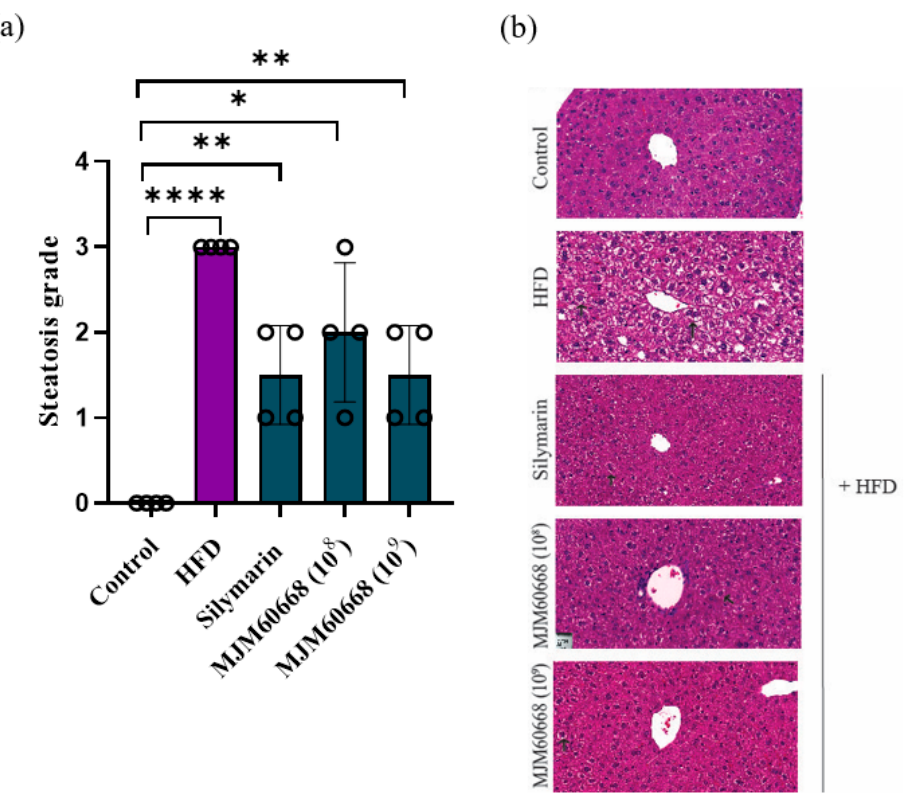
Figure 6. Liver biopsy of Non-alcoholic fatty liver disease (NAFLD) and steatosis grade. ( a ) Steatosis grade of the liver based on ballooned hepatocyte: 0 (normal, <5%), 1 (mild, 5–33%), 2 (moderate, 34–66%), 3 (severe, >66%). ( b ) Histologic features of NAFLD include ballooning and lobular inflammation. Arrow indicates ballooning hepatocyte. Image at a magnification of 20 × H&E staining. Data represented as mean ± S.E.M of three independent experiments. n = 4. * p < 0.05, ** p < 0.01, **** p < 0.0001 compared with control group.